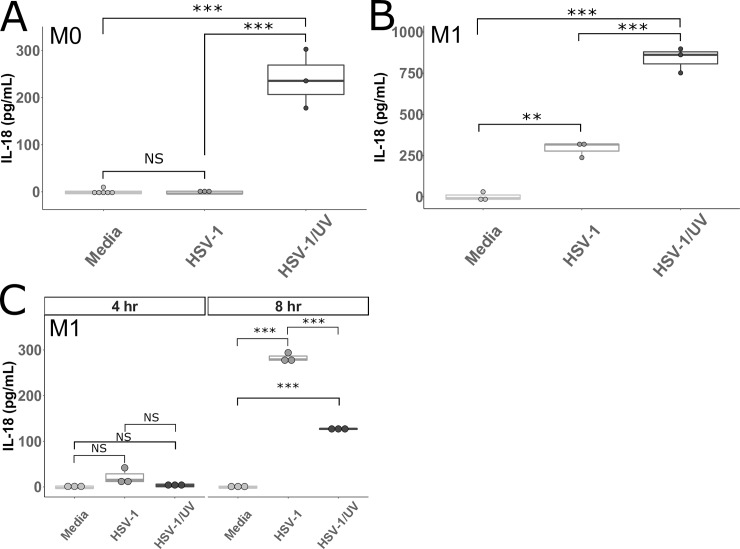
IL-18 produced by MDMs after infection with UV-irradiated HSV-1.A and B. Primary human MDMs cultured without (M0 A) or with IFNγ (M1 B) were incubated with HSV-1, UV irradiated HSV-1 (HSV-1/UV), or media for 24 hours. Cell culture supernatants were collected and assayed for IL-18. C. Primary human MDMs cultured with IFNγ were incubated with HSV-1, UV irradiated HSV-1 (HSV-1/UV), or media for 4 hours and 8 hours. Cell culture supernatants were collected and assayed for IL-18. Differences between indicated conditions within a cell type were determined by a one-way ANOVA with Tukey HSD post-hoc analysis. NS, *,**,*** indicate p-values >0.05, <0.05, <0.01, <0.001 respectively.